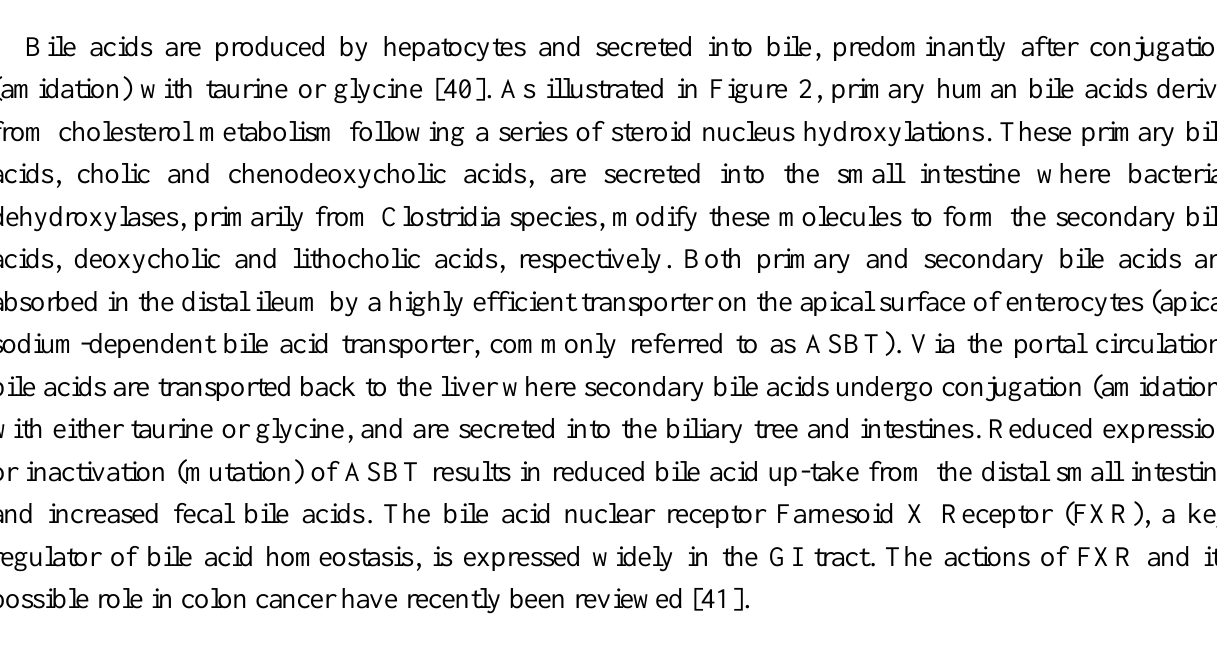
Figure 2. Human bile acid metabolism. Human bile acids derive primarily